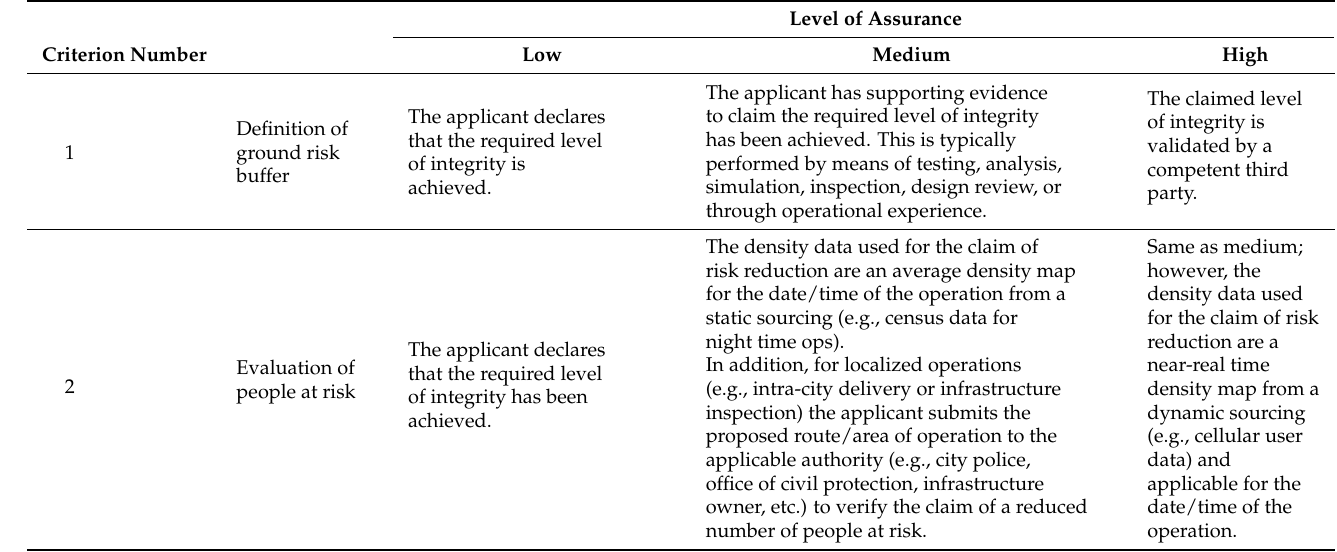
Table 7. Level of assurance assessment criteria for ground risk of non-tethered M1 mitigations